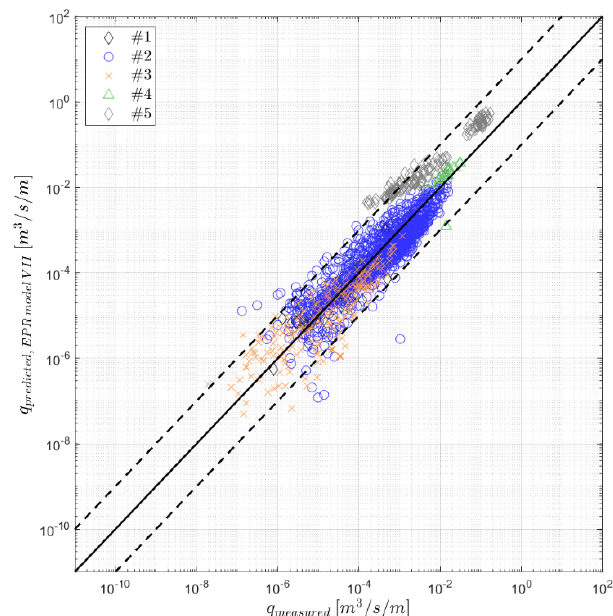
Figure 8. Comparison of overtopping prediction employing EPR model expression VII and measured overtopping discharge (solid line: prediction equal to measured rate; dashed lines: prediction equal to 10 times and 0.1 times the measured rate).